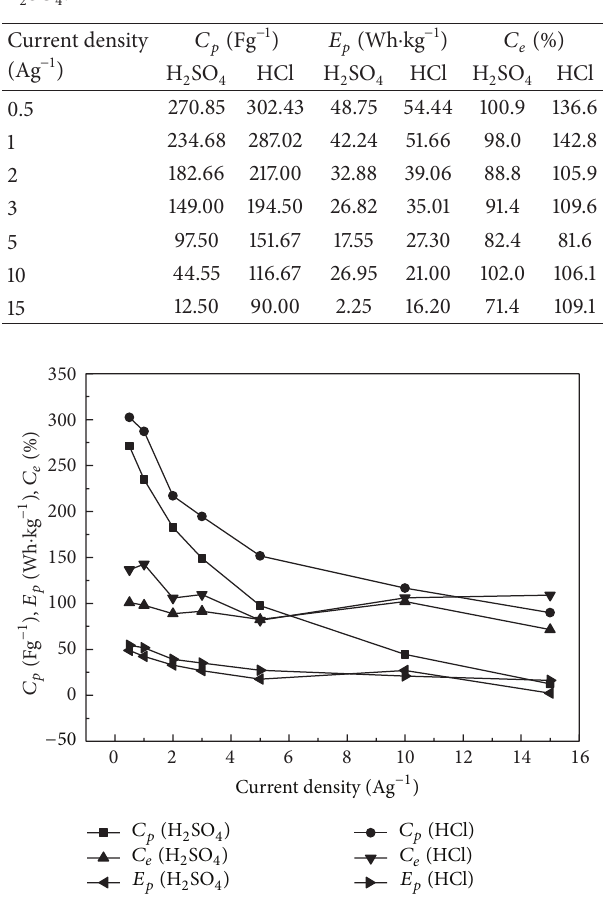
Figure 5: Relationship of specific capacitance ( 𝐶 𝑝 ), specific energy ( 𝐸 𝑝 ), and coulombic efficiency ( 𝐶 𝑒 ) of PANI from charge/discharge curves at current density from 0.5Ag −1 to 15 Ag −1 in 1MHCl and 1MH 2 SO 4